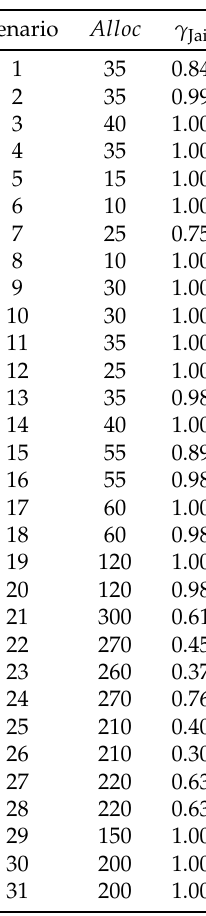
Table 14. Performance evaluation for NFF. Alloc values in Mbps.